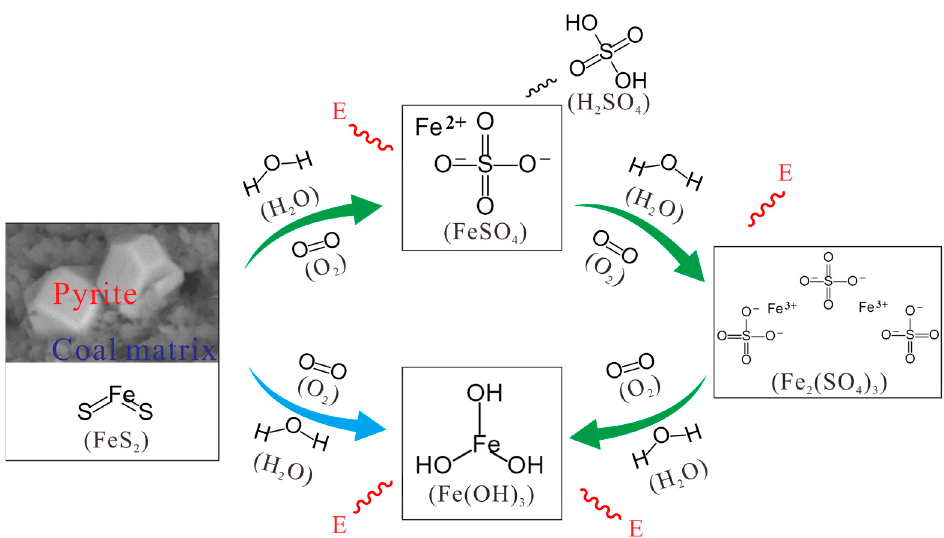
Figure 10. The schematic diagram of the cyclic oxidation exothermic reaction process of pyrite.